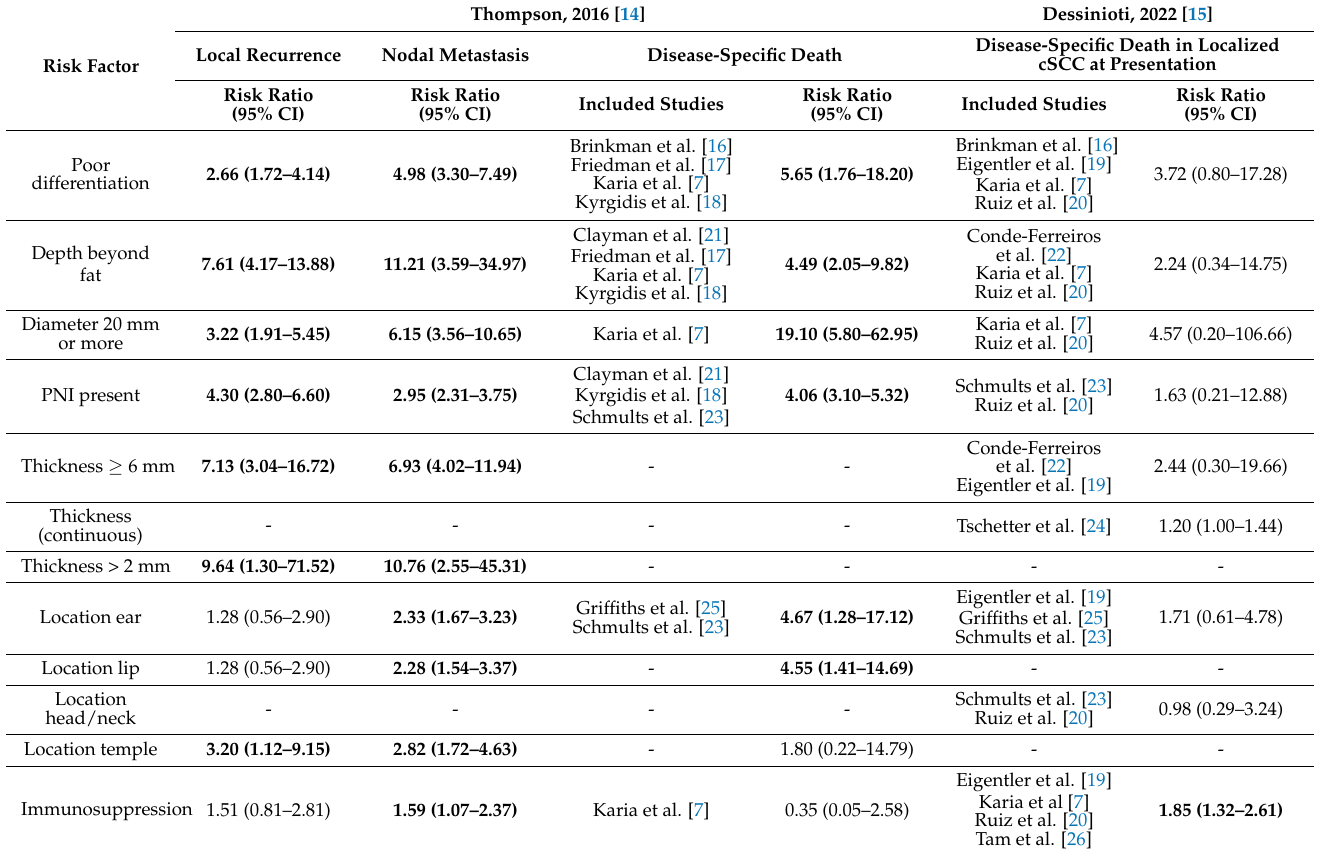
Table 2. Risk factors for local recurrence, nodal metastasis, and disease-specific death in meta-analyses. Statistically significant risk ratios are marked in